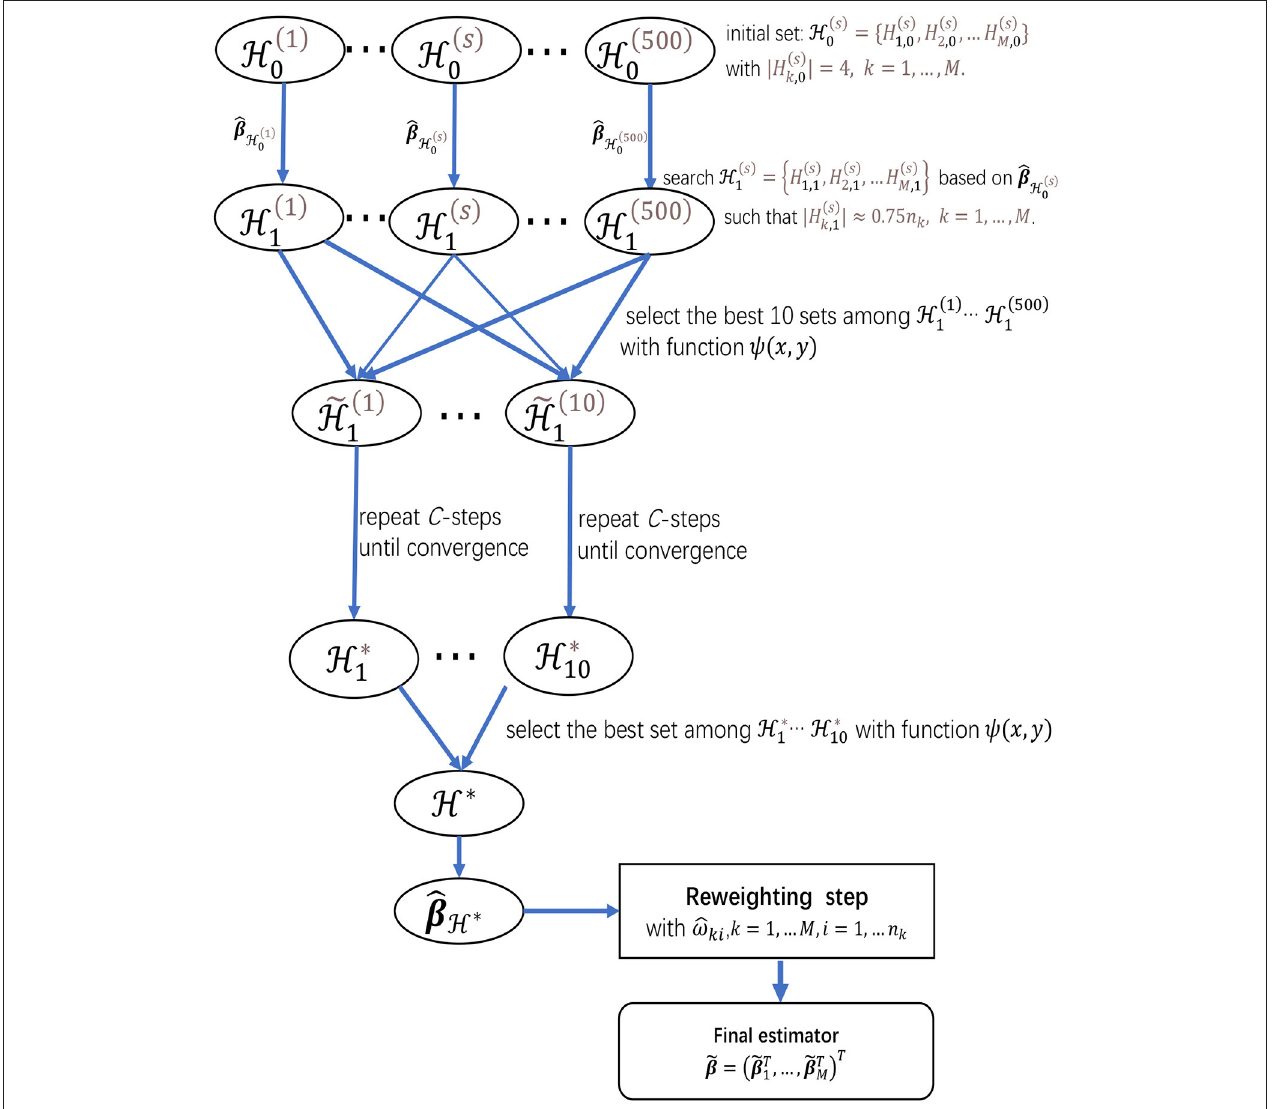
FIGURE 1 | The flow chart of the two-step procedure for meta-analyzing multiple studies, which provides a summarization for the searching procedure for H ∗ and the reweighting